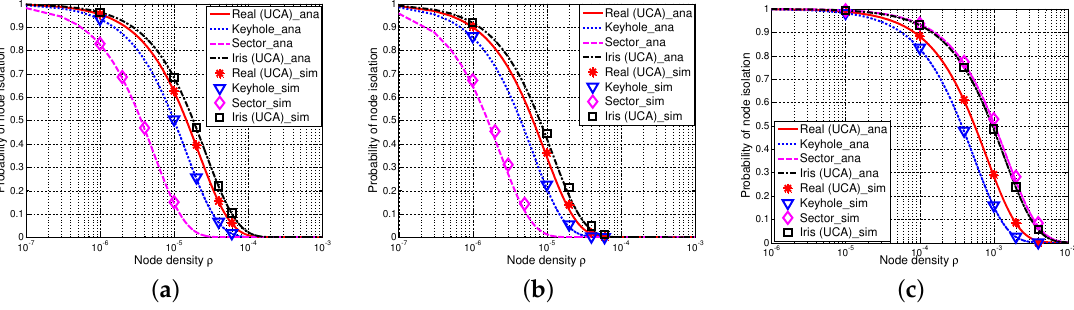
Figure 8. Probability of node isolation P ( iso ) with UCA antenna, keyhole, sector and iris-UCA models, where curves are analytical results and markers are simulation results. ( a ) α = 2.5, σ = 4; ( b ) α = 2.5, σ = 8; ( c ) α = 4, σ =